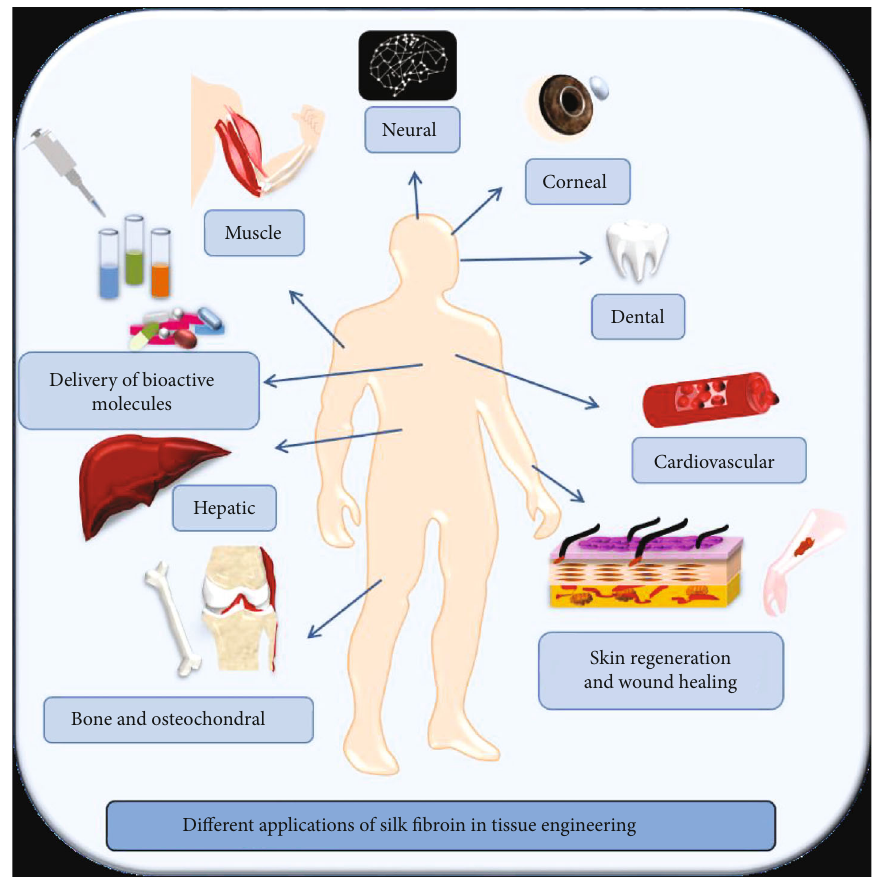
Figure 3: Silk fi broin: applications in tissue engineering and regenerative medicine (adopted from Gholipourmalekabadi et al.